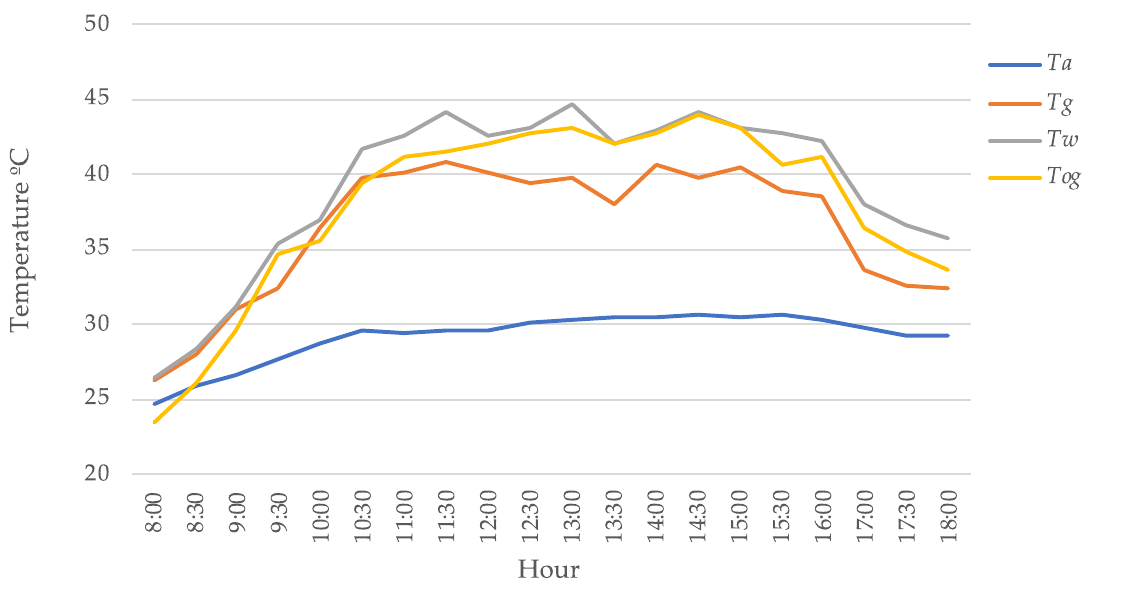
Figure 11. Average temperatures inside the prototype and in the ambience. The colors of the lines indicate the ambience (blue), glass temperature inside the solar still (red), water temperature in the basin (grey), and glass temperature outside the solar still (yellow).